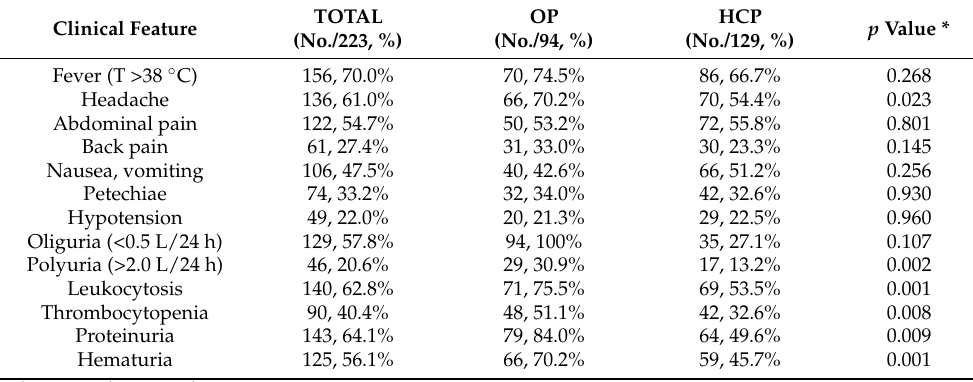
Table 3. Signs and symptoms of hantavirus infections as reported by 223 physicians, broken down as occupational physicians (OP, No. = 94) vs. all other medical health care providers (HCP) participating in the survey. Comparisons were performed by means of chi squared test (with Yates correction).